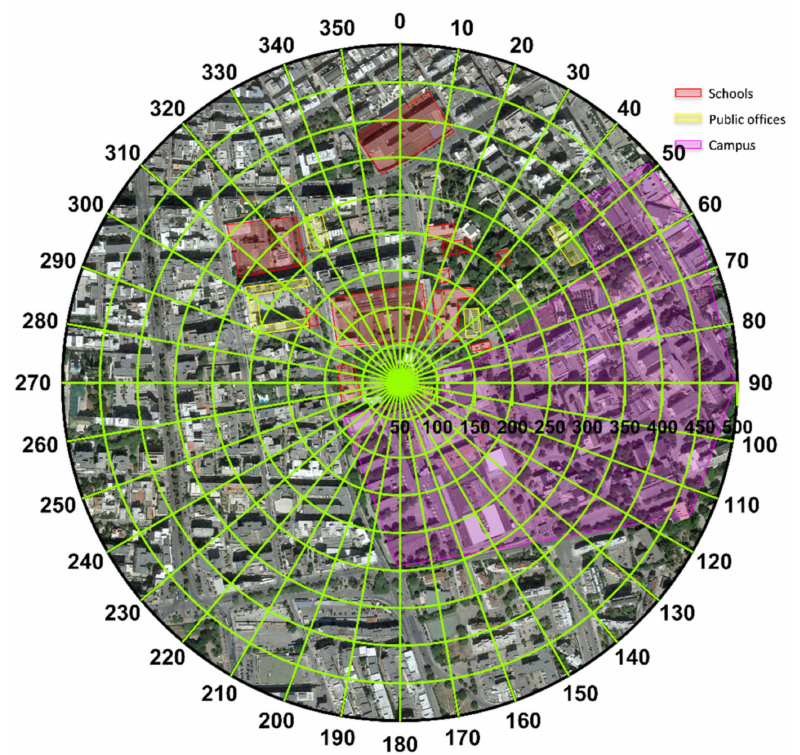
Figure 2. The area used for the footprint morphology analysis located around the measurement point: A circle of 500 m radius, divided in 324 cells of 50 m per sectors of 10 ◦ . The colored polygons on the map indicate the campus area (purple), the public buildings (yellow), and the schools